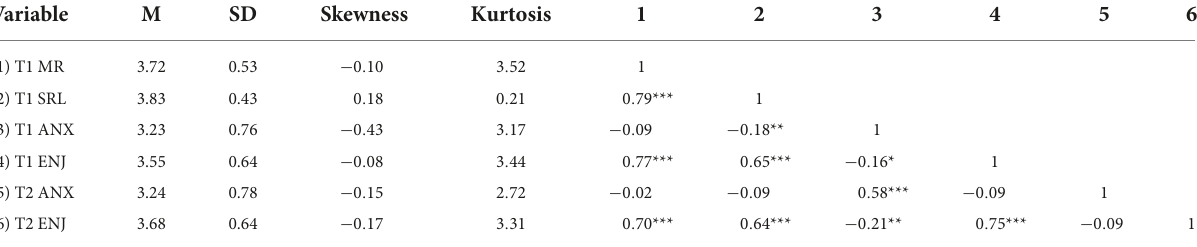
TABLE 1 Descriptive statistics and correlations before principal component analysis ( N = 230). Variable